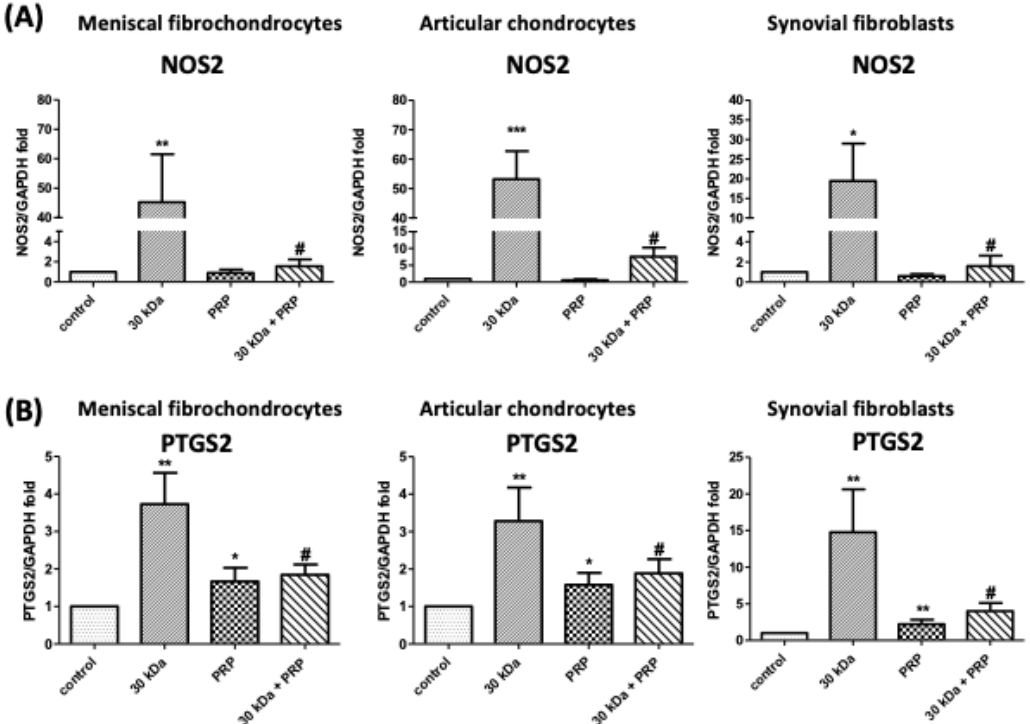
Figure 5. Effects of PRP on 30 kDa FN-f-induced NOS2 and PTGS2 gene expression in meniscal fibrochondrocytes, articular chondrocytes, and synovial fibroblasts. ( A ) PRP treatment suppressed upregulation of NOS2 and ( B ) PTGS2 (* p < 0.05, compared with control; ** p < 0.01, compared with control; *** p < 0.001, compared with control; # p < 0.05, 30 kDa + PRP vs. 30 kDa; n = 5 for each